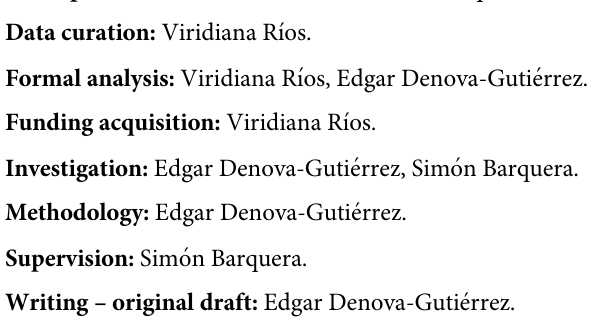
S1 Fig. Flowchart of the Mexican National Epidemiological Surveillance System for viral respiratory disease. S2 Fig. Standardized guideline for Epidemiological and Laboratory Surveillance of viral respiratory disease. S1 Table. Sociodemographic characteristics and chronic conditions of the study popula-